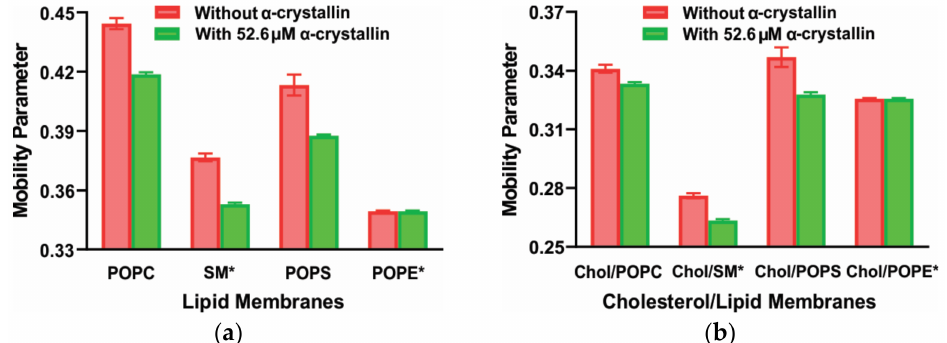
Figure 5. Mobility parameter of lipid (PL and sphingolipid) membranes with and without α -crystallin. ( a ) Individual lipid membranes, i.e., POPC, SM*, POPS, and POPE* (where * represents the presence of 20 mol% POPS); ( b ) Chol/POPC, Chol/SM*, Chol/POPS, and Chol/POPE* membranes with Chol/lipid mixing ratio of 0.3. The mobility parameter decreases for the individual lipid membranes (POPC, SM*, and POPS) and Chol/lipid membranes (Chol/POPC, Chol/SM*, and Chol/POPS) with an increase in α -crystallin concentration, indicating the decrease in the mobility of the membranes near the headgroup regions due to the binding of α -crystallin to these membranes. The mobility parameter for the POPE* and Chol/POPE* with Chol/POPE* mixing ratio of 0.3 membranes does not decrease in the presence of α -crystallin, because α -crystallin does not bind to these membranes. Redrawn with permission from [99,101,108], Copyright 2021, with permission from Taylor & Francis and